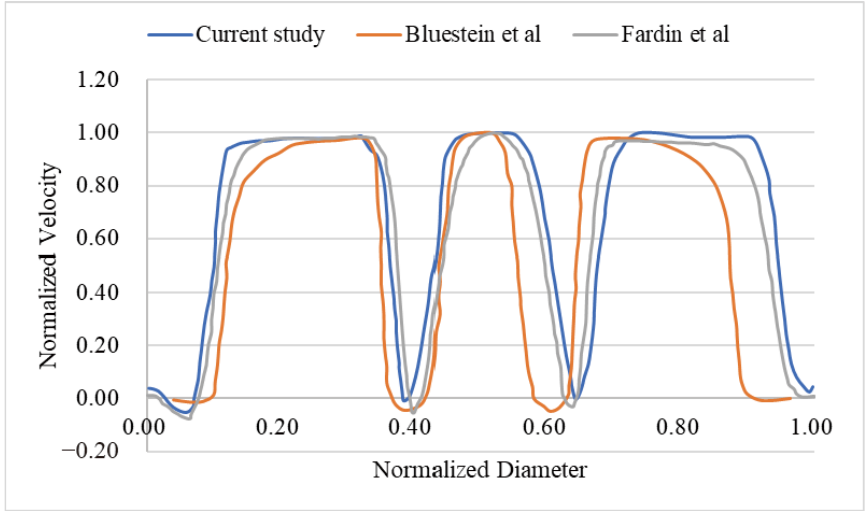
Figure 10. Normalized velocity curves on the centerline behind the leaflet in the current study com- pared to previous experiments [46] and calculations